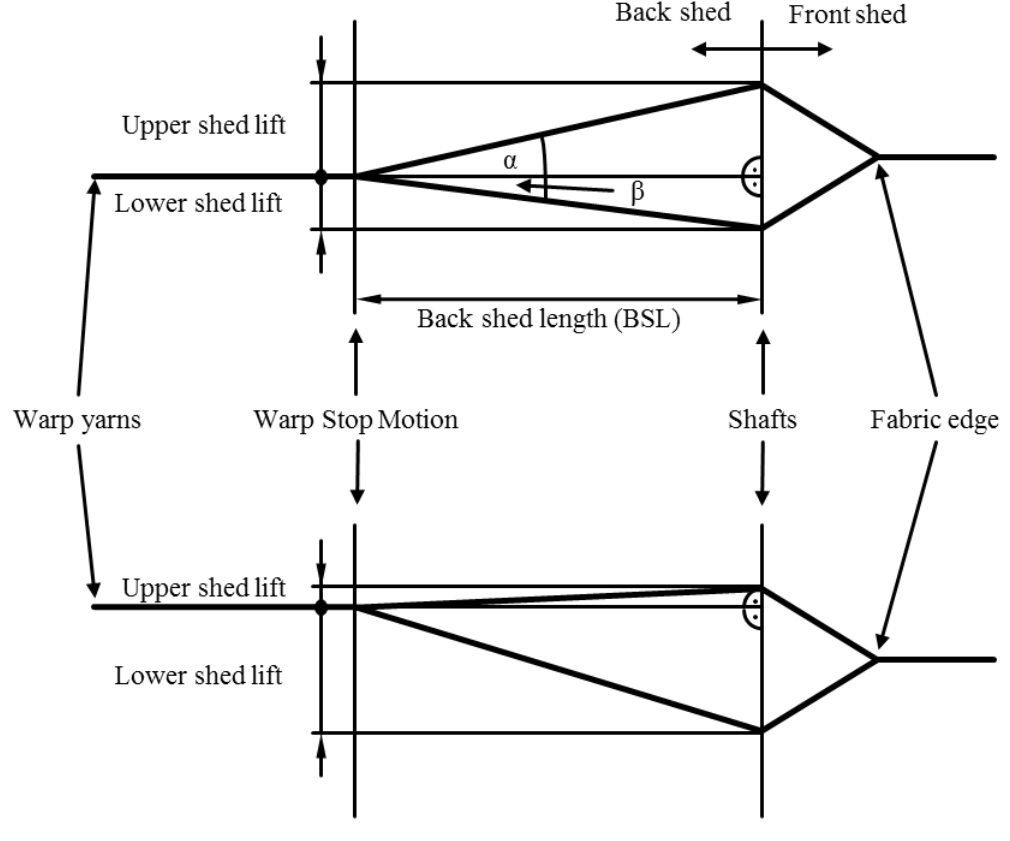
Figure 2. Two schematic weaving shed